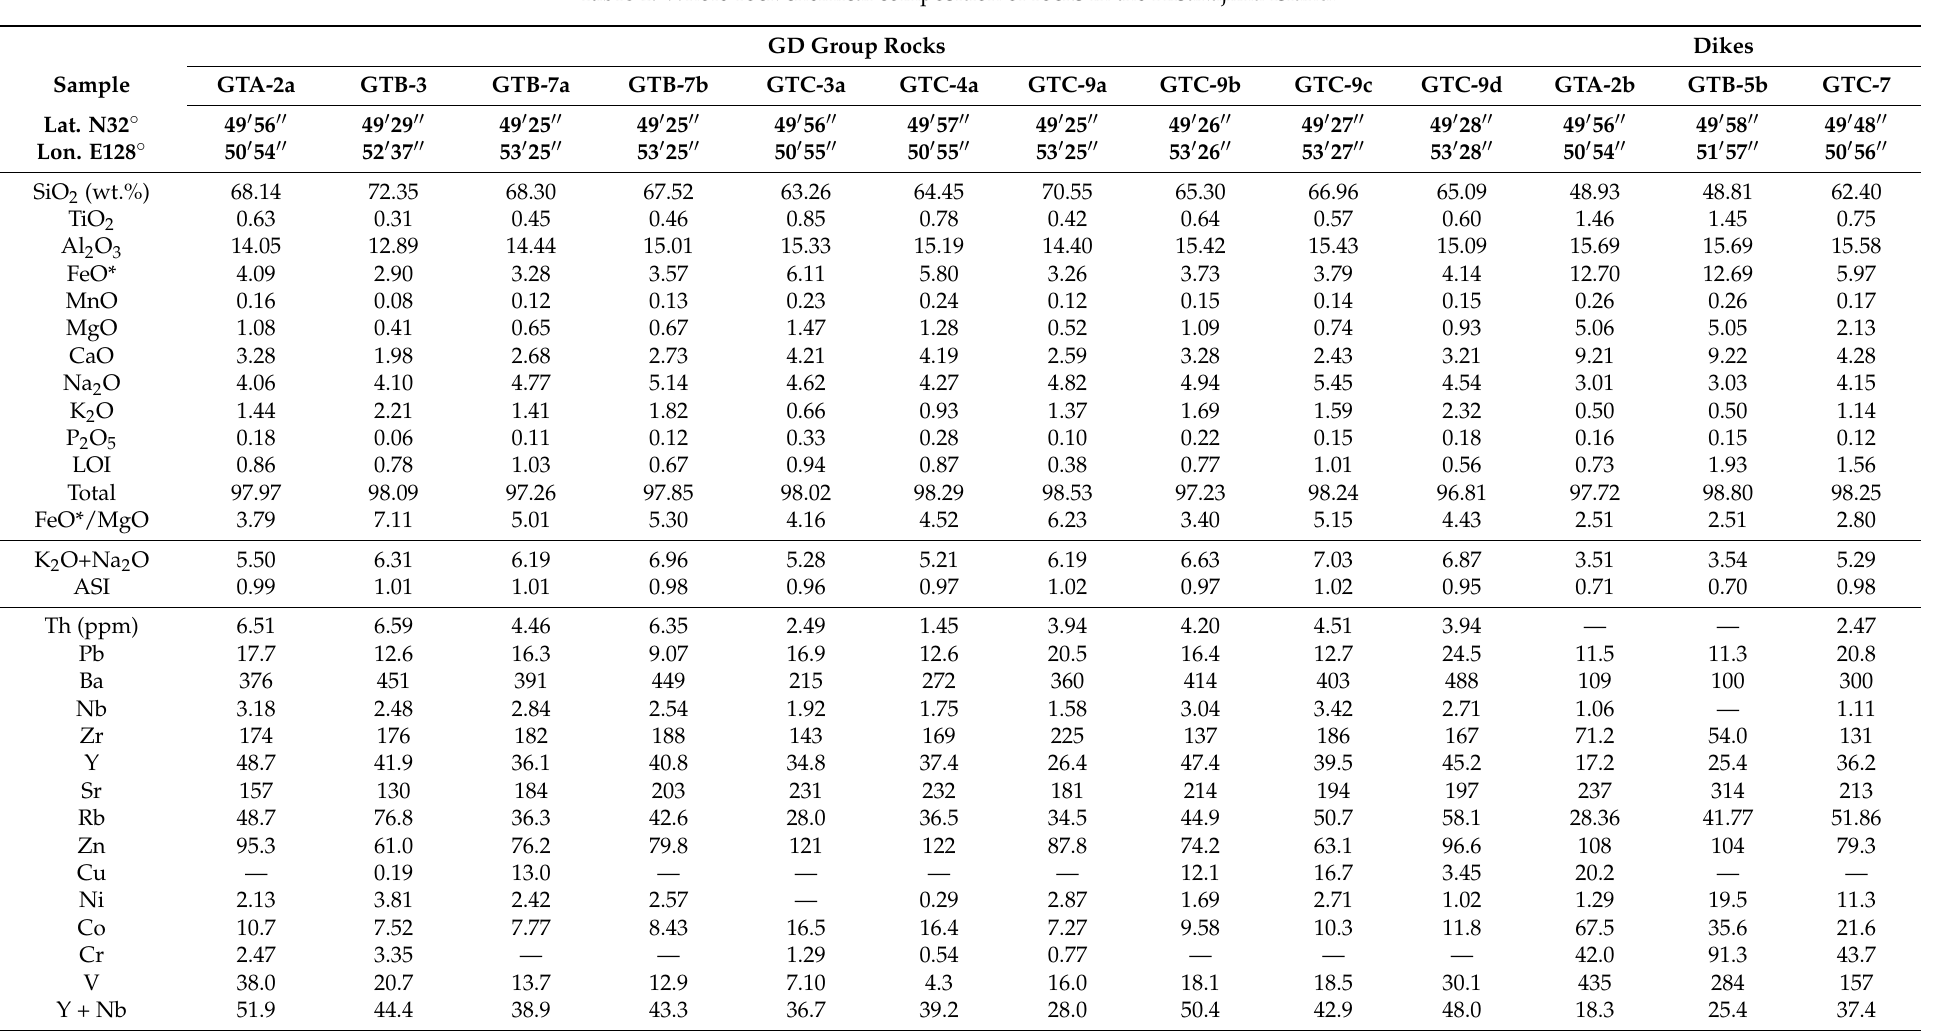
Table 1. Whole-rock chemical composition of rocks in the Hisakajima